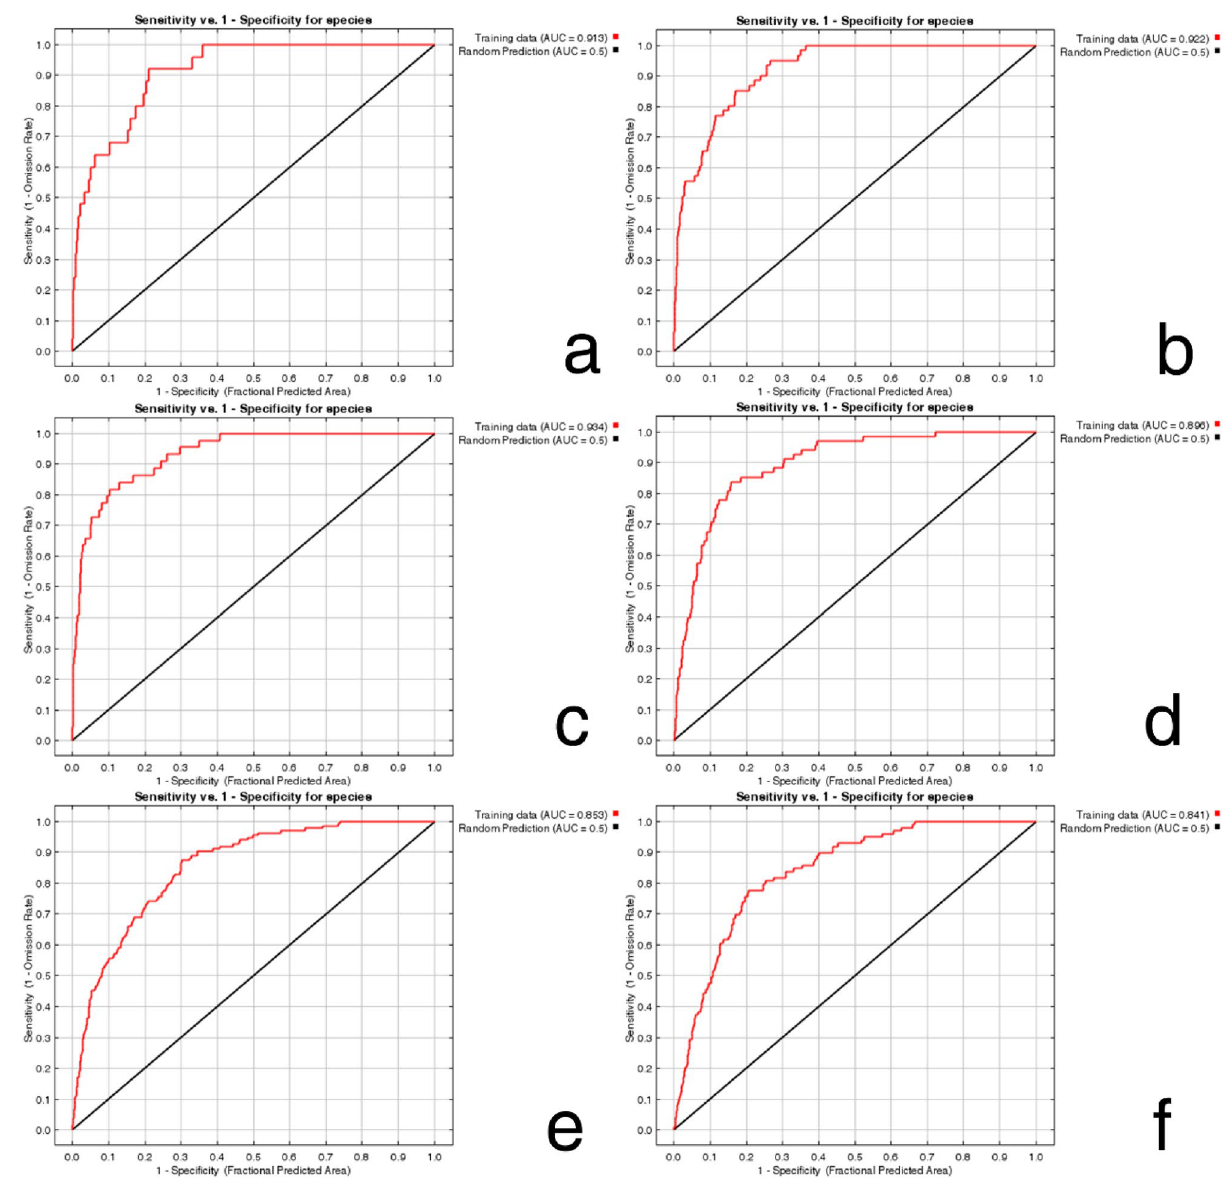
Figure 3. The receiver operating characteristic (ROC) curve and area under the curve (AUC) of six important quarantine species: ( a ) Crenidorsum aroidephagus , ( b ) Aleurothrixus trachoides , ( c ) Paraleyrodes minei , ( d ) Nasonovia ribisnigri , ( e ) Macrosiphum euphorbiae , ( f ) Viteus vitifoliae . Training data (red line), random prediction (black line). Figures were created using R version 4.04 (https:// www.r- proje ct.